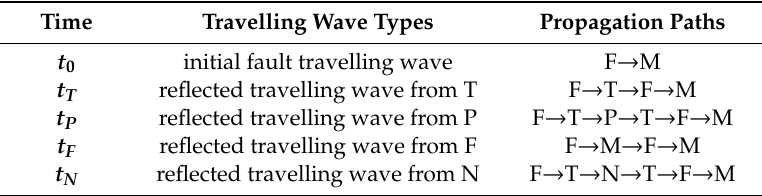
Table 4. Travelling wave types with their reach times.